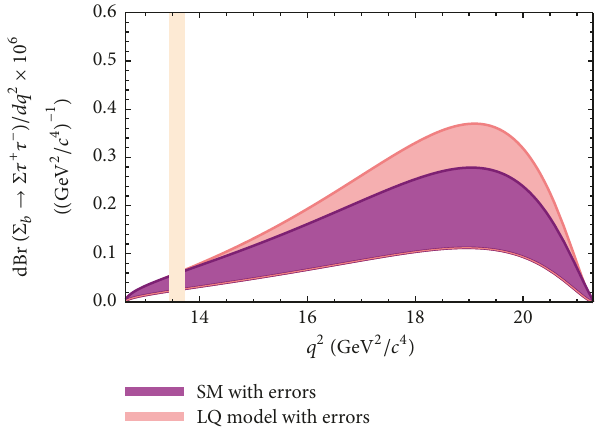
Figure 4: The dependence of the differential branching ratio on 𝑞 2 forthe Σ 𝑏 → Σ𝜏 + 𝜏 − transitionintheSMandLQmodels.Thevertical shaded band indicates the charmonia veto region.